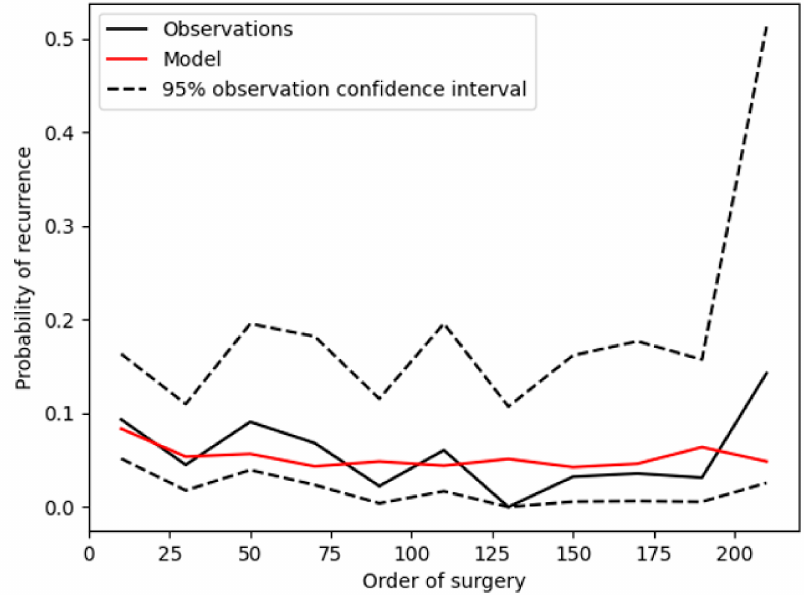
Figure A1. Analysis performed on all hospitals.